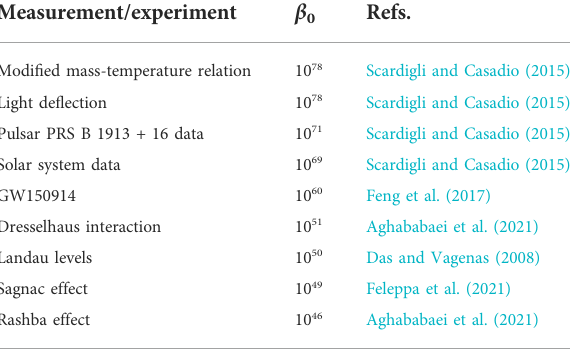
TABLE 1 Some bounds on the GUP parameter β 0